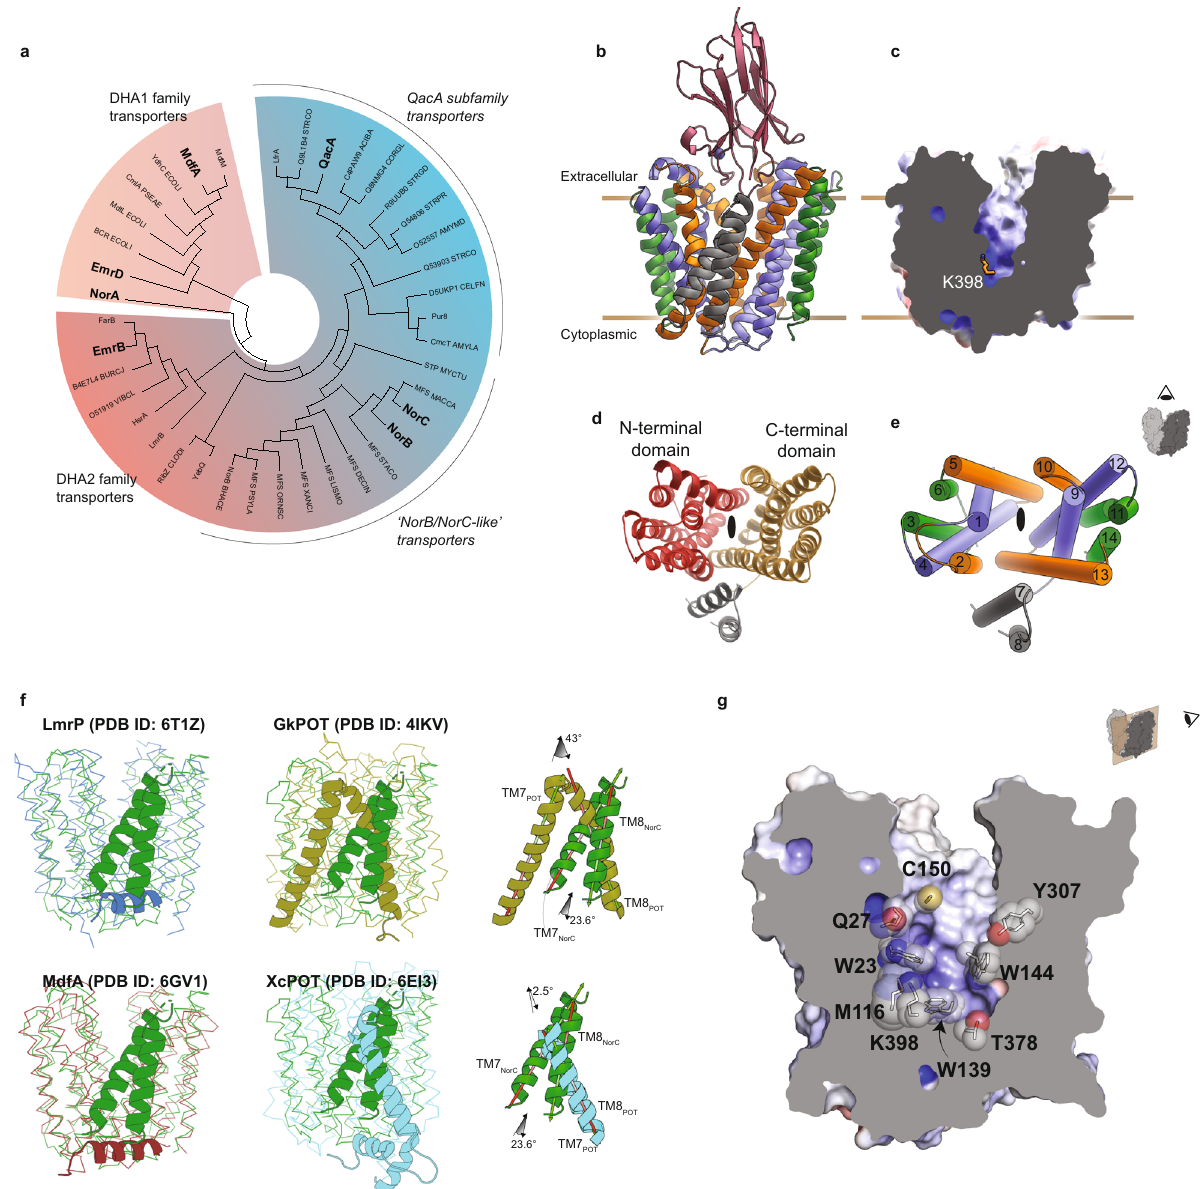
Fig. 1 Phylogeny and X-ray structure of NorC. a Radial phenogram of DHA1 and DHA2 transporters. Characterized DHA2 transporters and their close homologs have been categorized with QacA/EmrB and their homologs for their sequentially coherent residues. b Side view of NorC bound to the ICab in an outward-open conformation. The transmembrane helices have been grouped in repeats of three helices to depict symmetric organization; vestibule lining TM helices 1, 4, 9, and 12 are in blue, 2, 5, 10, and 13 lining the domain interface in orange, 3, 6, 11, and 14 in green, and helices 7 and 8 are in gray. c APBS electrostatic representation showing positively charged region of the vestibule near the cytoplasmic end of NorC, owing to K398 (shown as sticks). d , e Note that TM7 and TM8 lie outside the primary pseudo-two-fold symmetric helical bundles that surround the vestibule. f Structural superposition of LmrP (blue, RMSD = 3.0 Å), MdfA (brown, RMSD = 2.5 Å), GkPOT (olive, RMSD = 4.4 Å) and XcPOT (cyan, RMSD = 4.2 Å) with NorC; angular differences between TMs 7 and 8 of NorC and those of POTs are shown in the same superposition. MdfA and LmrP are members of the DHA family while GkPOT and XcPOT are proton-dependent oligopeptide symporters from Geobacillus kaustophilus and Xanthomonas campestris , respectively. g Solid section of NorC showing vestibular